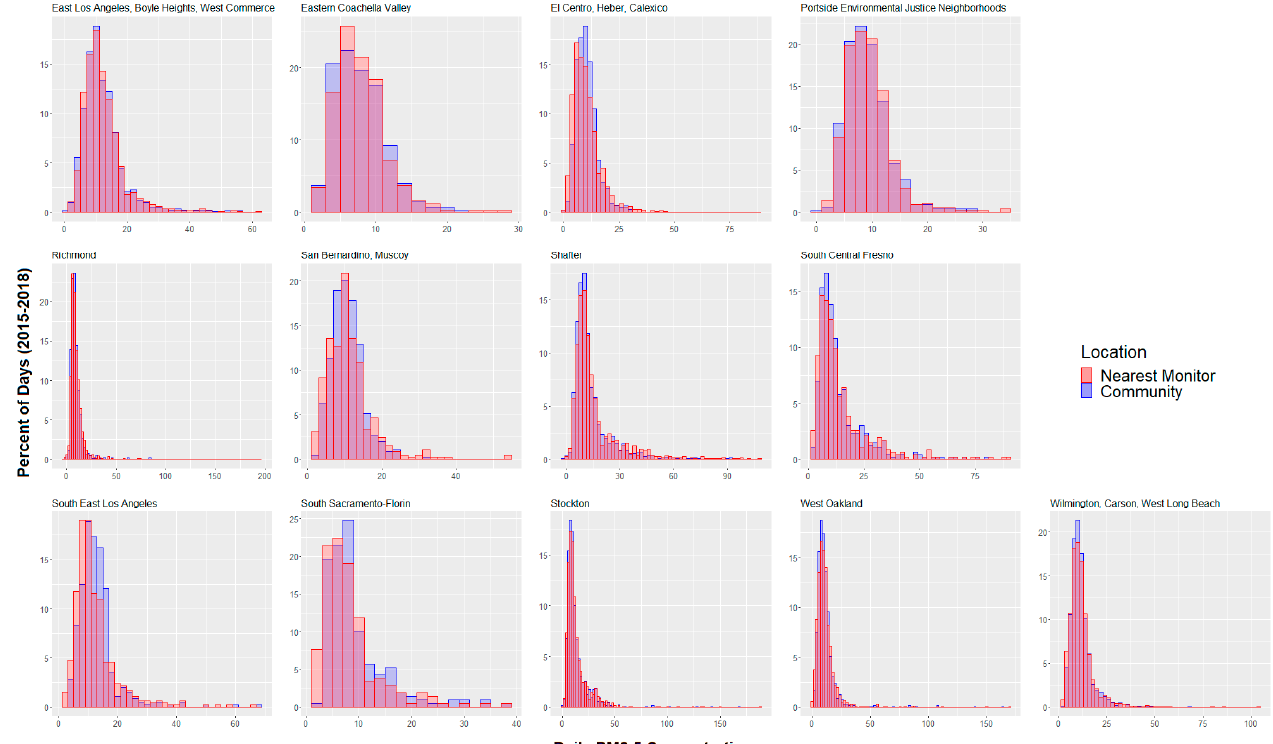
Figure 3. Comparing the frequency of daily PM 2.5 concentrations (µg/m 3 ) from satellite-derived community averages (shown in blue) and nearest ground monitors (shown in red) in each California CAPP Community (2015–2018).